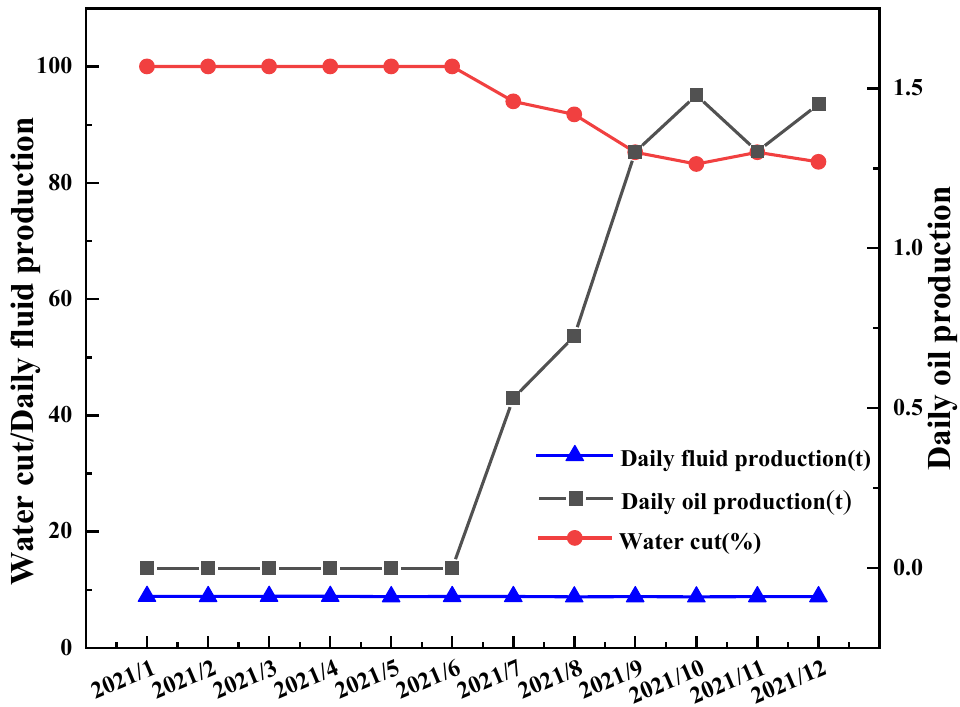
Figure 10. Dynamic curves of production in Oil Well G42.